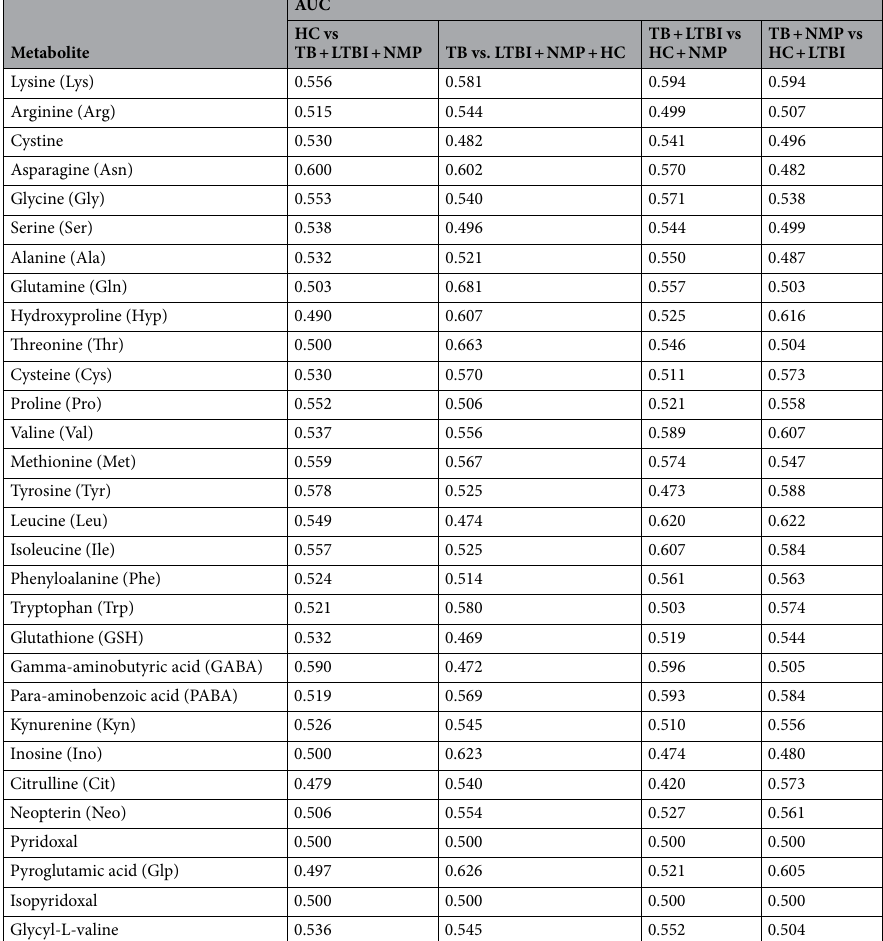
Table 4. Results of the ROC analyses of metabolites measured in sera. AUC area under curve, HC M.tb- uninfected healthy controls, LTBI latently M.tb infected individuals, NMP patients with nonmycobacterial pneumonia, TB active tuberculosis patients.